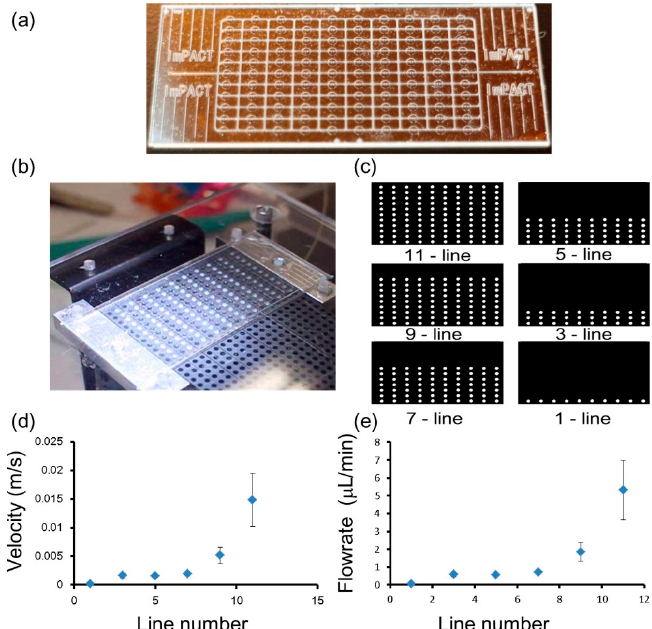
Figure 6. Pump demonstration experiment using different numbers of valves. ( a ) The fabricated prototype of the all-glass microfluidic device containing 110 valves; ( b ) Experimental set-up of the microfluidic device with the piezoelectric head containing 110 piezoelectric units; ( c ) The numbers of valves used to demonstrate the pump function; ( d , e ) Plots showing the dependence of the flow velocity in the channel or the flow rate, and the number of valve lines.